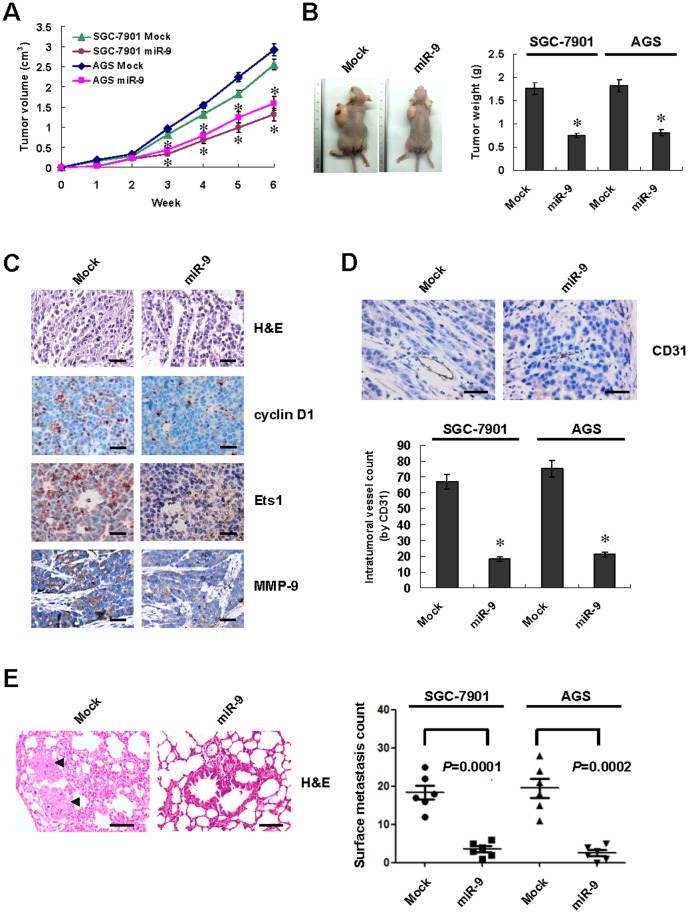
miR-9 attenuated the growth and metastasis of gastric cancer cells in vivo.
A and B, hypodermic injection of SGC-7901 or AGS cells stably transfected with miR-9 precursor into athymic nude mice (n = 5) resulted in decreased size and weight of subcutaneous xenograft tumors than those transfected with negative control vector (mock, n = 5). C, hematoxylin and eosin (H&E) and immunohistochemical staining revealed that stable transfection of miR-9 precursor resulted in decreased expression of cyclin D1, Ets1, and MMP-9 within tumors. Scale bars: 100 µm. D, the CD31-positive mean vessel density was decreased within tumors formed by cancer cells stably transfected by miR-9 precursor. Scale bars: 100 µm. E, in the experimental metastasis assay, cancer cells stably transfected with miR-9 precursor established significantly fewer metastatic lung colonies (arrowheads) in athymic nude mice (n = 6). Scale bars: 100 µm. The symbol (*) indicates a significant decrease from mock.